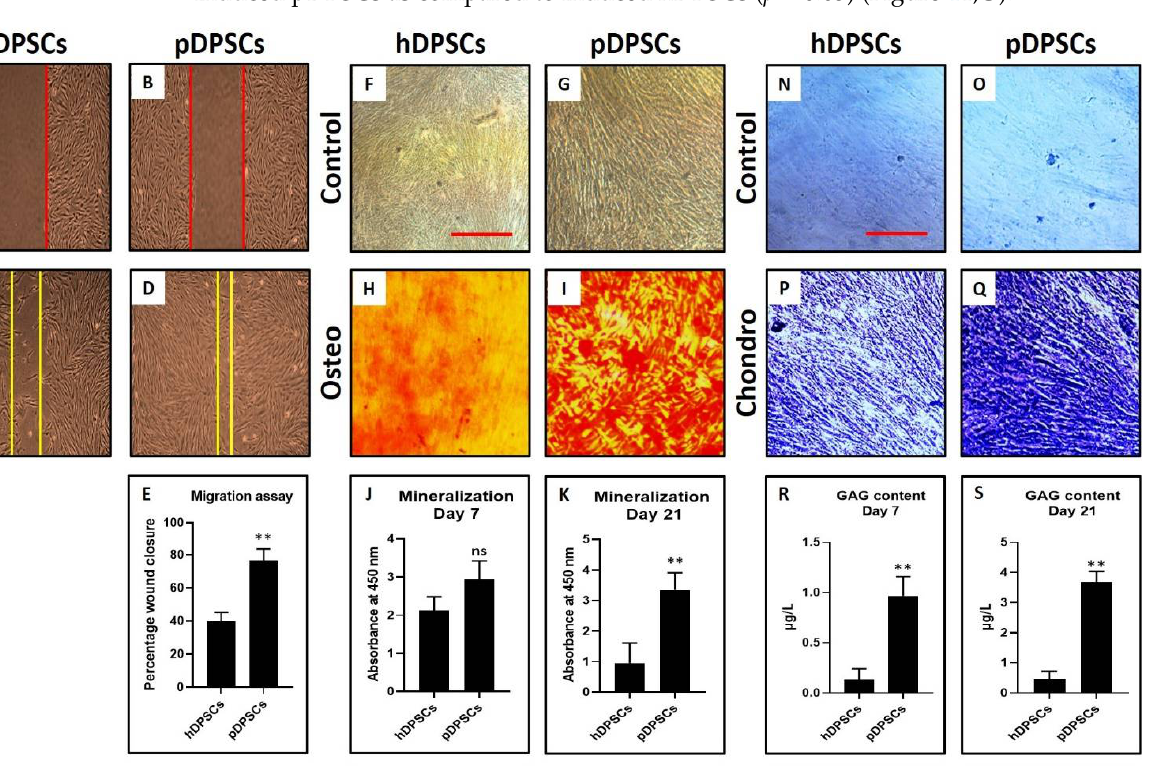
Figure 6. Assessment of migration, osteogenic differentiation and chondrogenic differentiation in DPSCs from healthy and periodontitis-affected teeth after cryopreservation. ( A – E ) comparative analysis of the migratory ability of hDPSCs and pDPSCs. ( F – I ) comparative analysis of osteogenic differentiation in hDPSCs and pDPSCs. ( J , K ) comparative analysis of mineralization in osteogenically induced hDPSCs and pDPSCs at day 7 and day 21. ( L , M ) comparative analysis of osteogenesis-related genes RUNX2 and OCN in osteogenically induced hDPSCs and pDPSCs at day 21. ( N – Q) comparative analysis of chondrogenic differentiation in hDPSCs and pDPSCs. ( R , S ) comparative analysis of GAG content in chondrogenically induced hDPSCs and pDPSCs at day 7 and day 21. ( T , U ) comparative analysis of chondrogenesis- related genes SOX9 and ACAN in chondrogenically induced hDPSCs and pDPSCs at day 21. Experiments were repeated in triplicates for n = 3. ns: not significant, * p < 0.05 and ** p < 0.01. hDPSCs: dental pulp stem cells from healthy teeth, pDPSCs: dental pulp stem cells from periodontitis-affected teeth, Osteo: osteogenic induction, RUNX2 : Runt-related transcription factor 2, OCN : osteocalcin, Chondro: chondrogenic induction, GAG: glycosaminoglycan, SOX9 : SRY-box transcription factor 9 and ACAN : aggrecan.